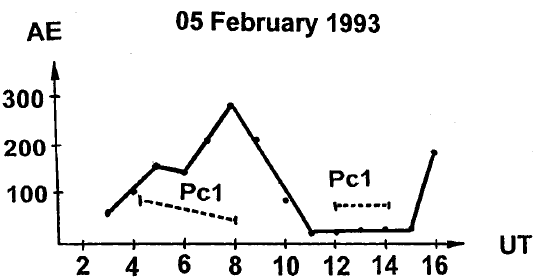
Fig. 4. Temporal variation of the AE -index ( solid line ) and the trend of the central frequency ( dashed lines ) of nonstationary and stationary pearl pulsations observed at Sodankyla¨ on February